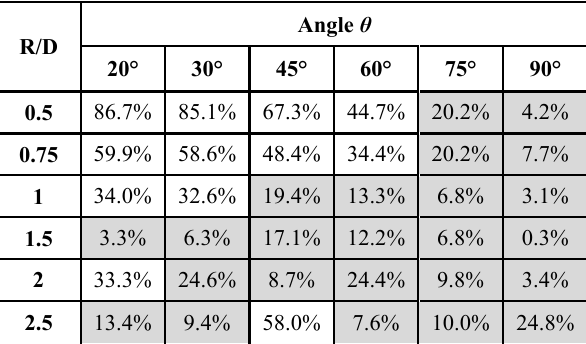
Table 5. Modulus of relative error of coefficients